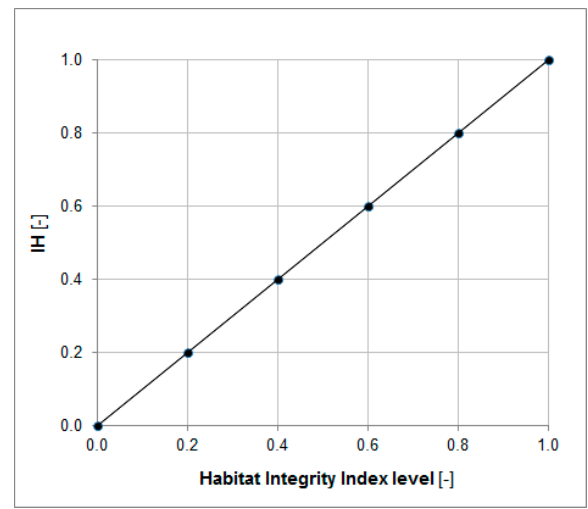
Figure 5. Utility function of the IH indicator. The values on the x-axis, i.e., the values of the IH index, range between 0 (maximum negative effect of the withdrawal on the hydromorphological components) and 1 (no impacts). The corresponding values on the y-axis are the normalized scores of the indicator, representing the satisfaction level of the related stakeholders: They vary from 0 (no satisfaction) to 1 (maximum satisfaction).